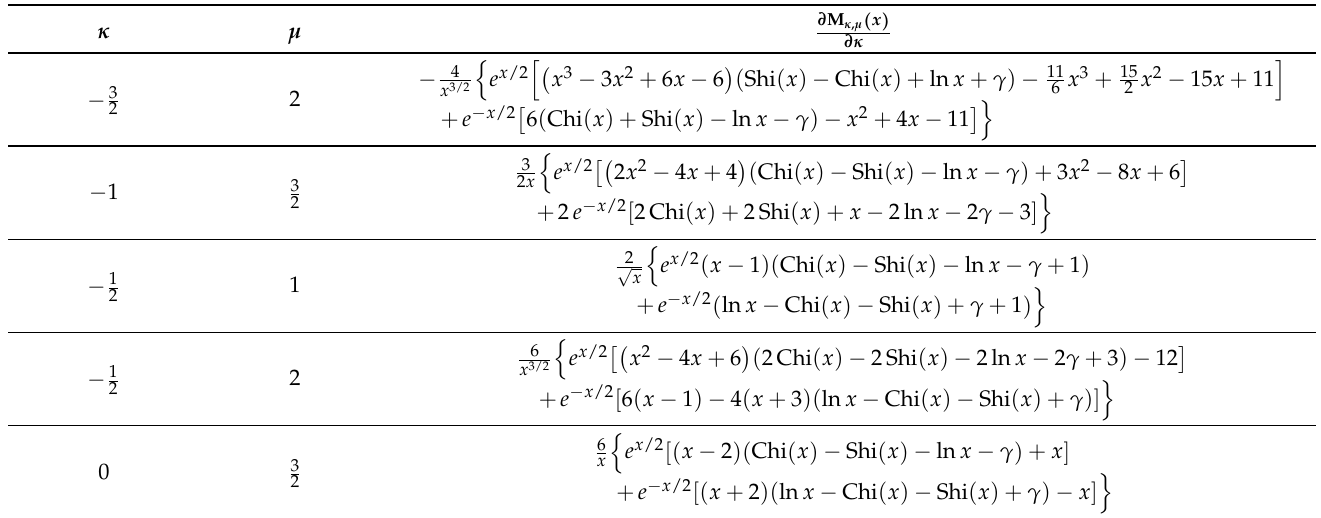
Table 6. Derivative of M κ , µ with respect to κ using